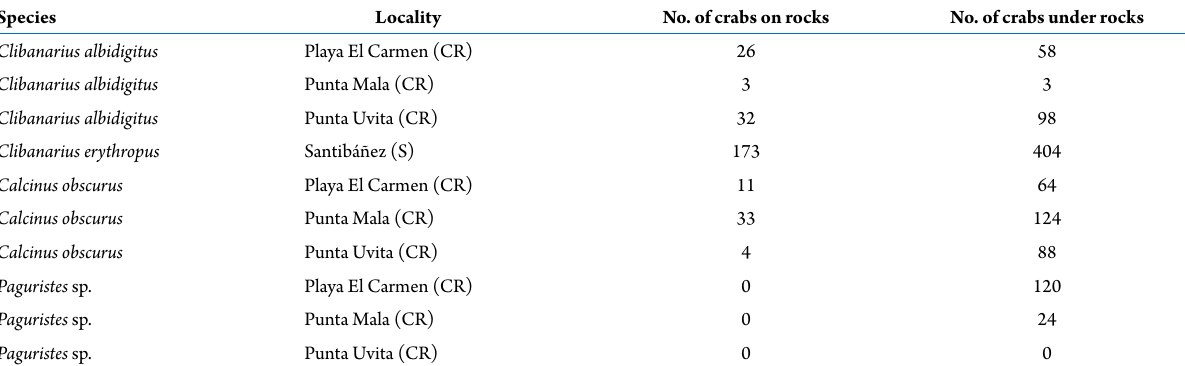
Table 1. Hermit crab species and number of hermit crabs, which were found at low tide air-exposure on rocks and those which were found clustered under rocks in each sampling locality, CR: Costa Rica; S: Spain. Species